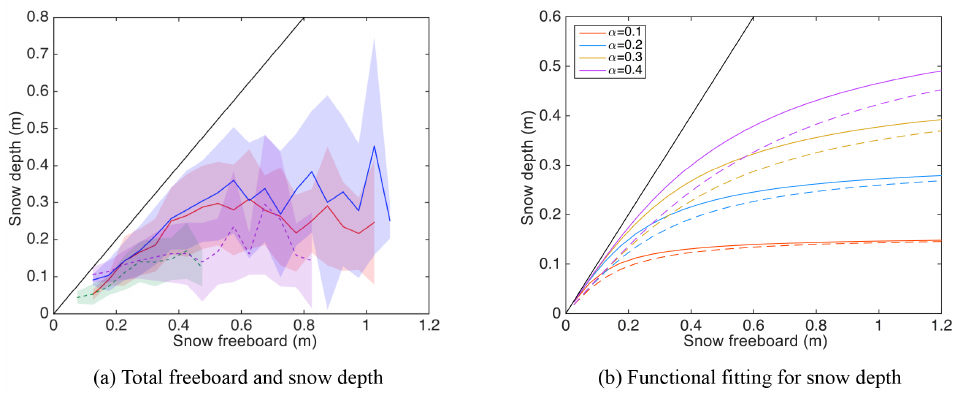
Figure 4. Statistics of snow depth from OIB at the local scale of retrieval. Panel (a) shows the mean and the ± 1 standard deviation of the snow depth within each snow freeboard bin (from 0 to 1.5m by an interval of 5cm), shown by lines and shaded areas for four realistic cases of OIB. Panel (b) shows the nonlinear fitting of snow depth over snow freeboard (Eq. 3) under representative s values (0.71 for FYI and 0.95 for MYI) and various values of α . Solid color lines are for MYI and dashed ones for FYI. The solid black line is y = x